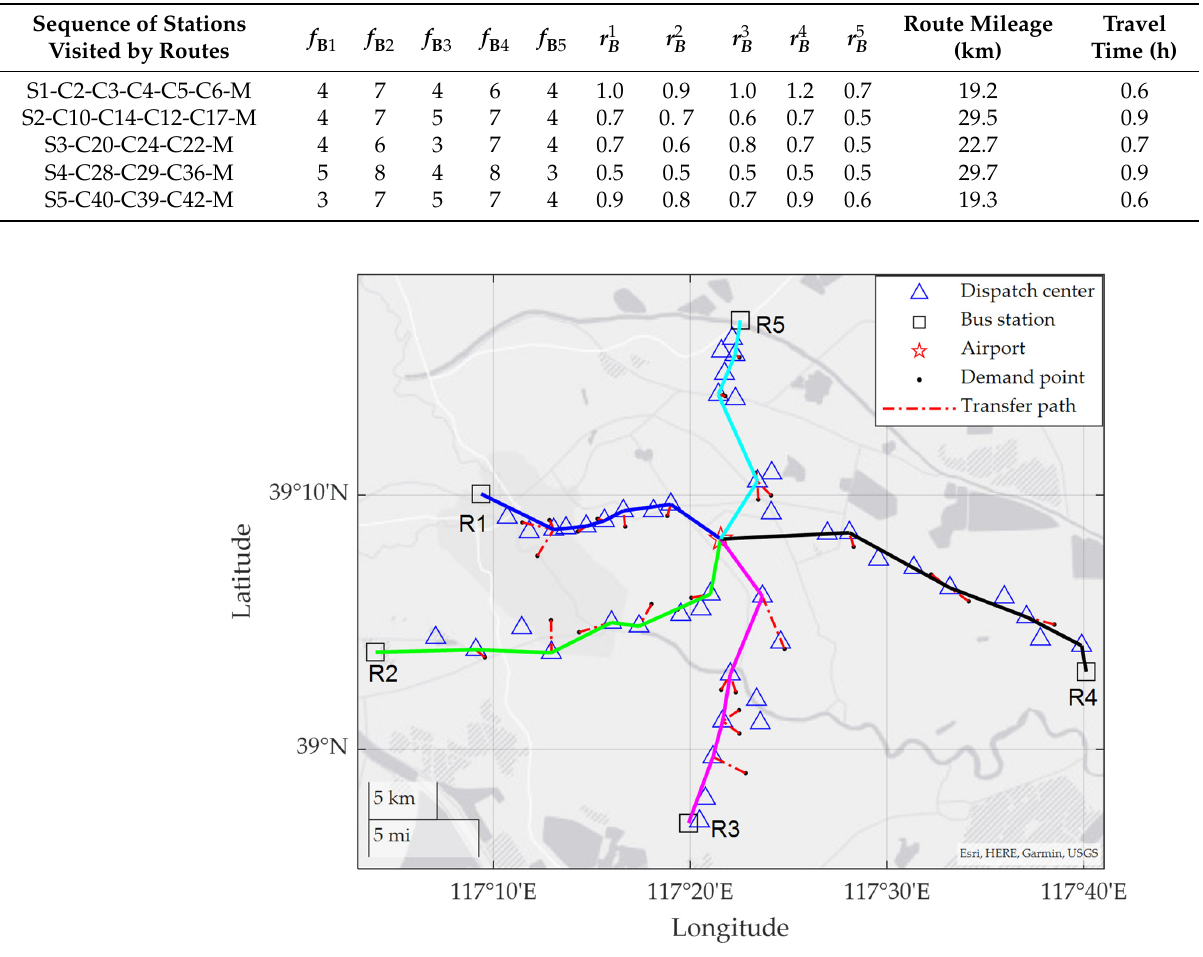
Figure 7. Roadmap of the optimal solution. The proposed and conventional models were compared, as shown in Figure 8.